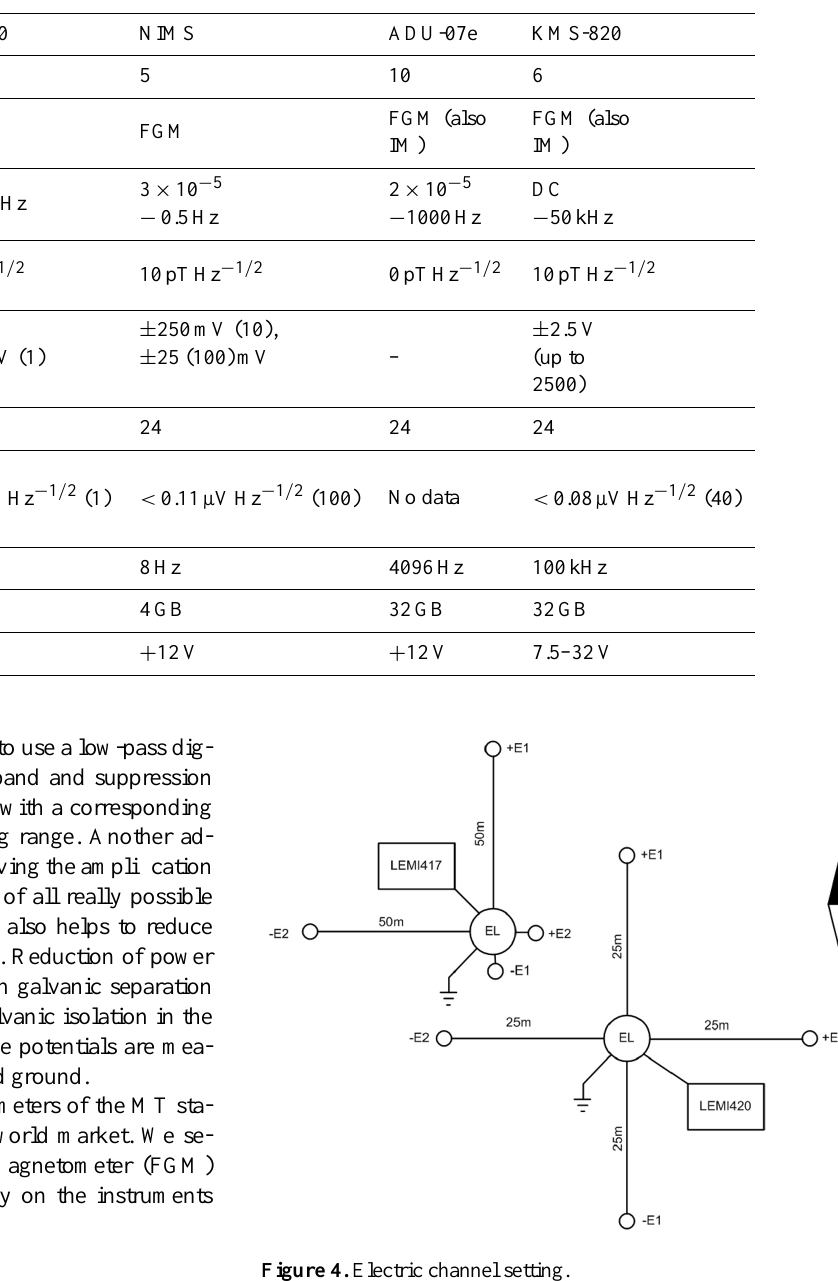
Table 2. Comparative table of main MT station parameters of leading manufacturers.